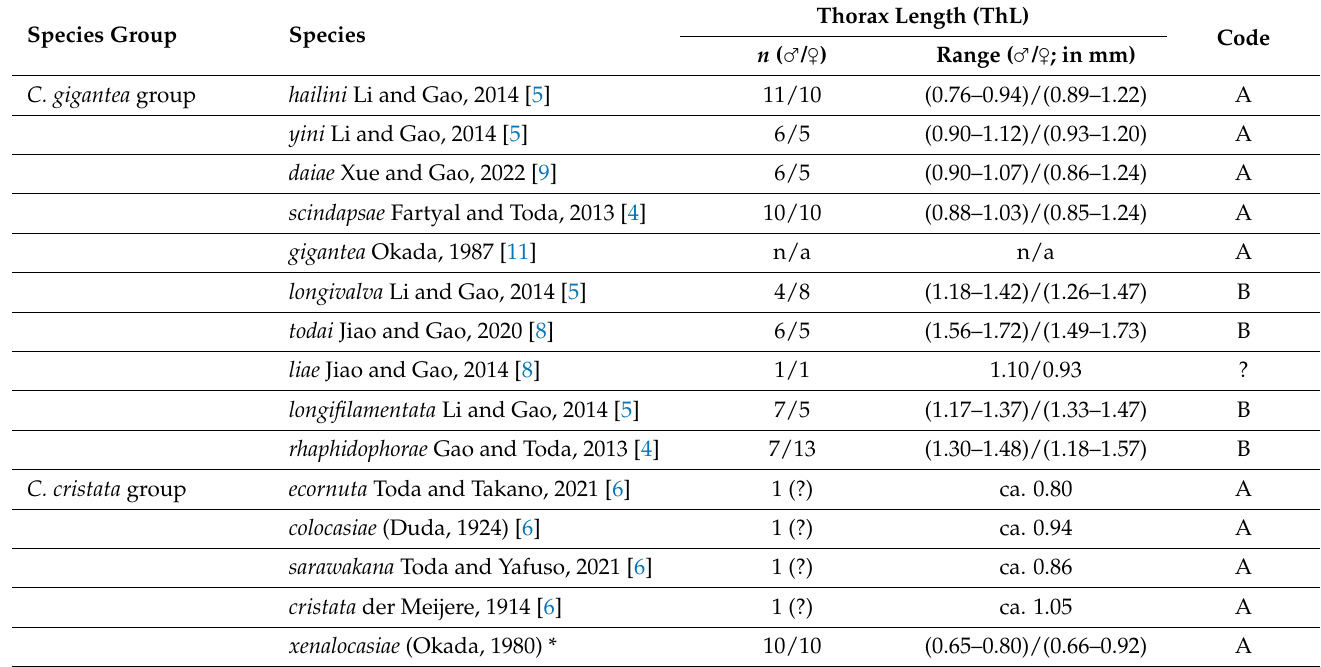
Table A2. Data of body size (thorax length) [23] of 15 Colocasiomyia species compiled from the literature or as newly collected